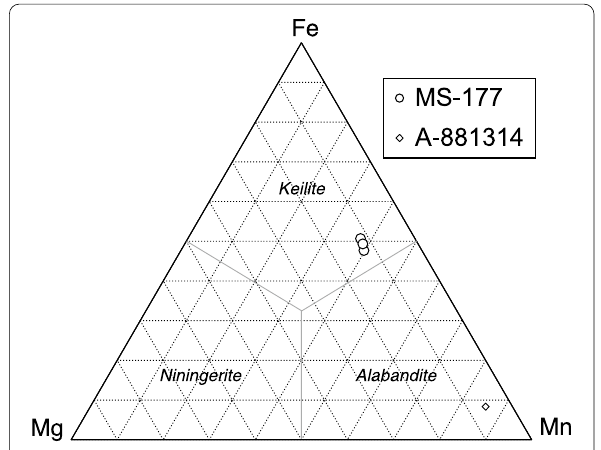
Fig. 6 Compositions of (Mg,Mn,Fe) S phases in MS-177 and A-881314 on FeS–MgS–MnS plot (atomic